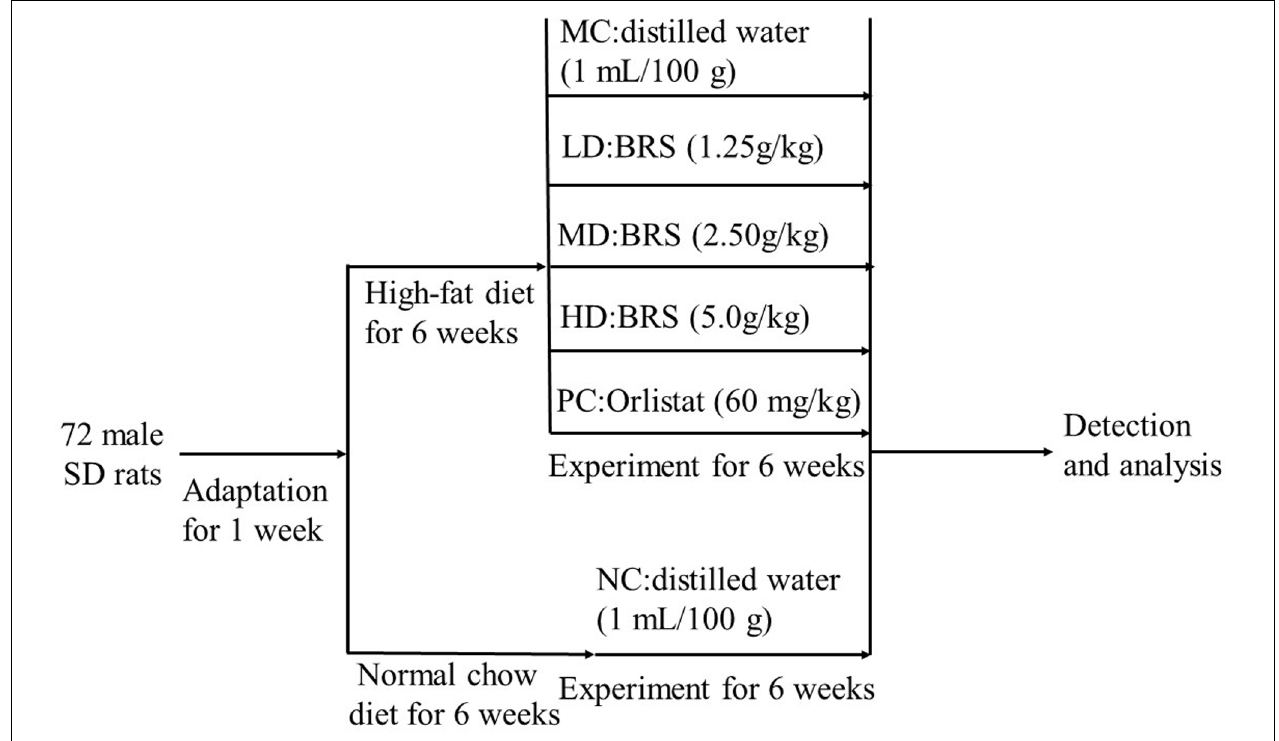
FIGURE 1 | Animal experimental protocol and design. MC-model control group, LD-low dose group of BRS, MD-middle dose group of BRS, HD-high dose group of BRS, PC-positive control group, NC-normal control